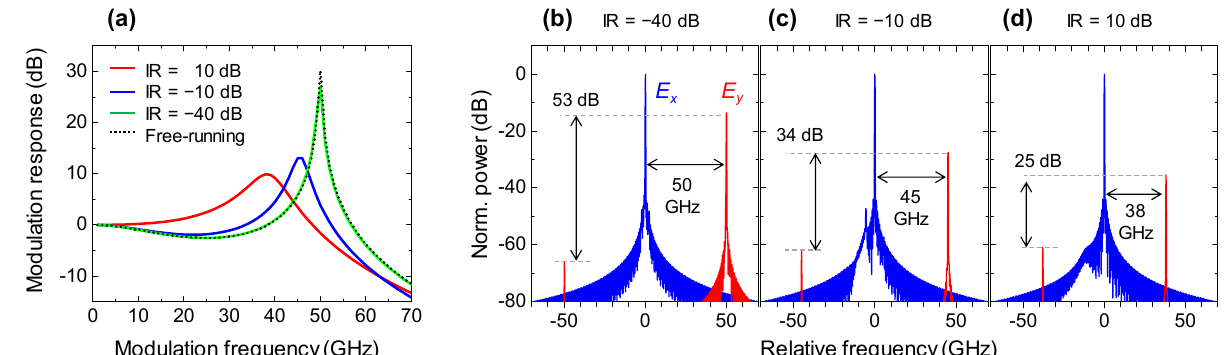
Figure 5. ( a ) Spin polarization modulation response under injection locking condition with different IRs and under free- running condition; Polarization-resolved optical spectra under spin polarization modulation of injection-locked spin-VCSEL. ( b ) IR = − 40 dB, f m = 50 GHz; ( c ) IR = − 10 dB, f m = 45 GHz; ( d ) IR = 10 dB, f m = 38 GHz. Blue and red curves indicate x and y polarization components, respectively. These are calculated with ∆ f of 0 and γ p of 50 GHz.